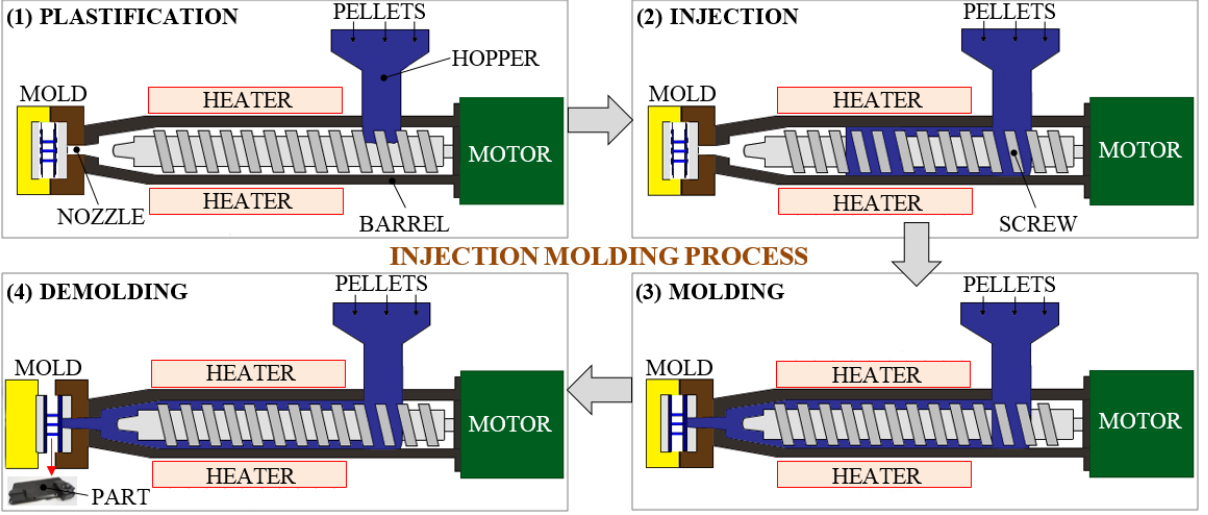
Figure 5. Normal injection molding process cycle: plastification, injection, molding and demolding.